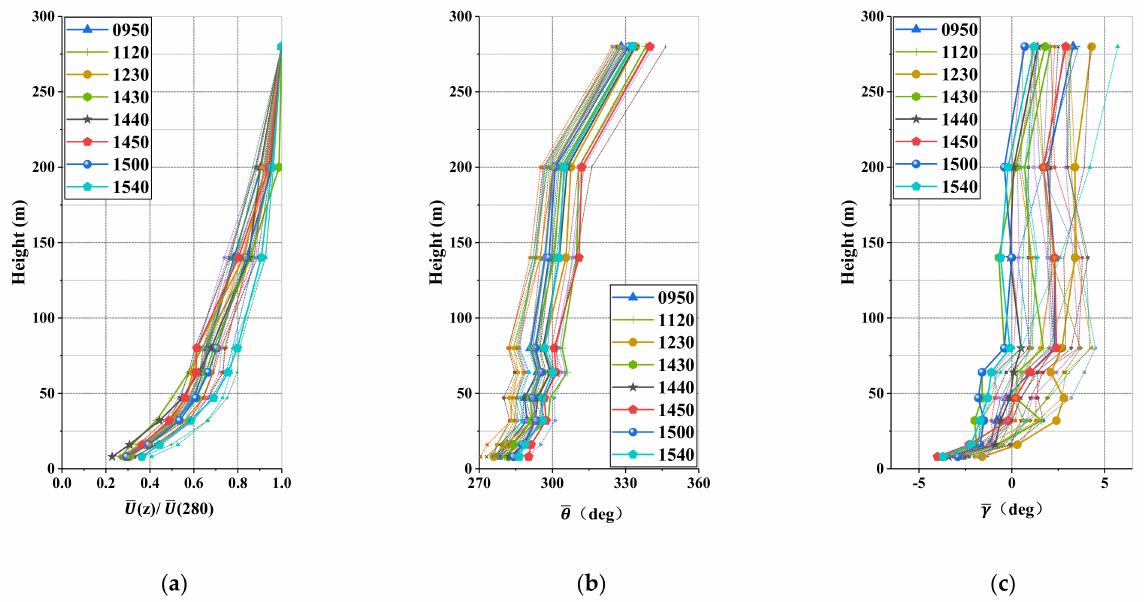
Figure 14. The profiles of the 10-min mean wind speed nomalized by the related value at 280 m ( a ), the horizontal direction ( b ) and the wind angle of attack ( c ) related to the strong wind records of the synoptic event which occured on 5 May 2017.